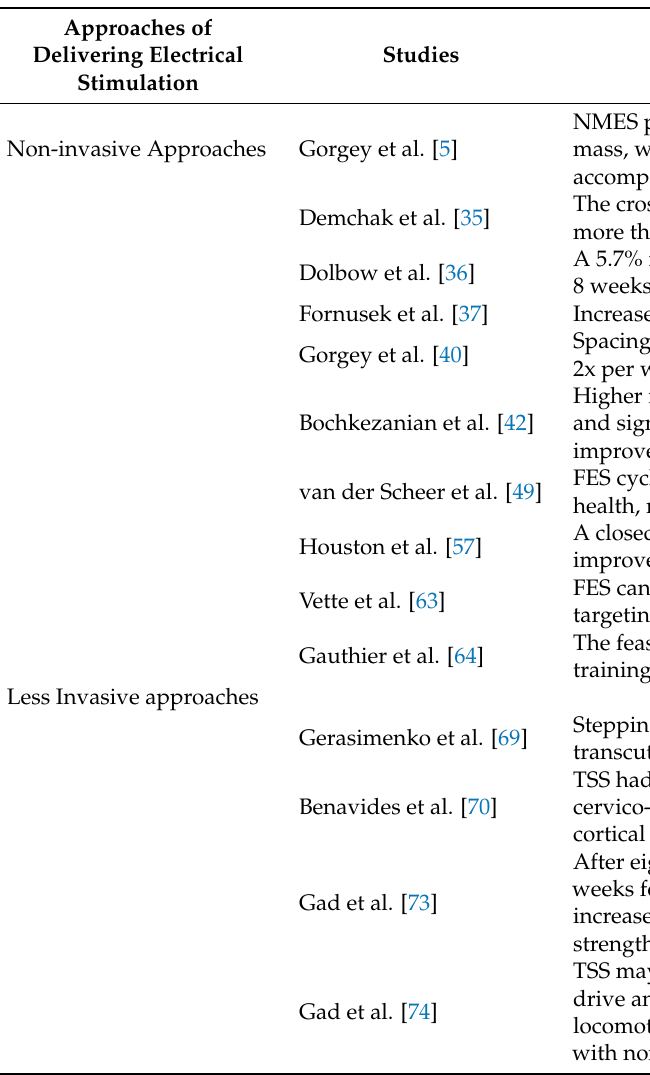
Table 1. Summary of the major findings that reflect key studies in non-invasive and invasive applications of electrical stimulation to enhance functions after